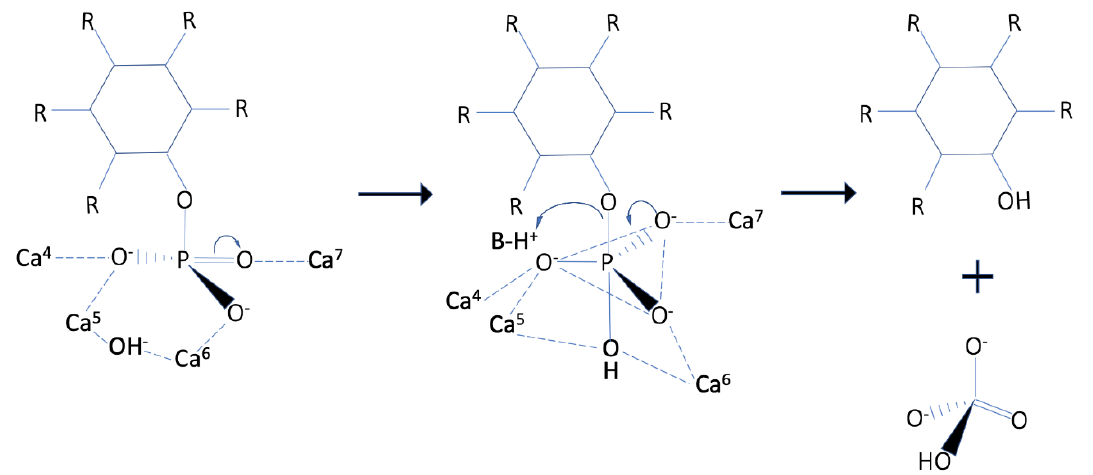
Figure 2. Catalytic mechanism of BPP. The Ca2+ ions decrease pKa of water forming hydroxide ion (deprotonated form of water). OH- donates an electron pair to the positive phosphorus in phosphate to form intermediate state. Then, the general acid donates a proton, thus cleaving the phosphoester bond to release phosphate group.